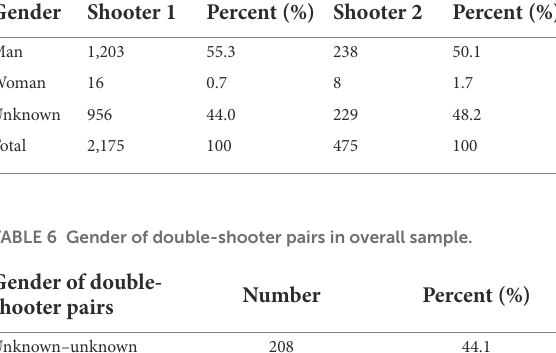
TABLE 5 Gender of mass shooters in overall